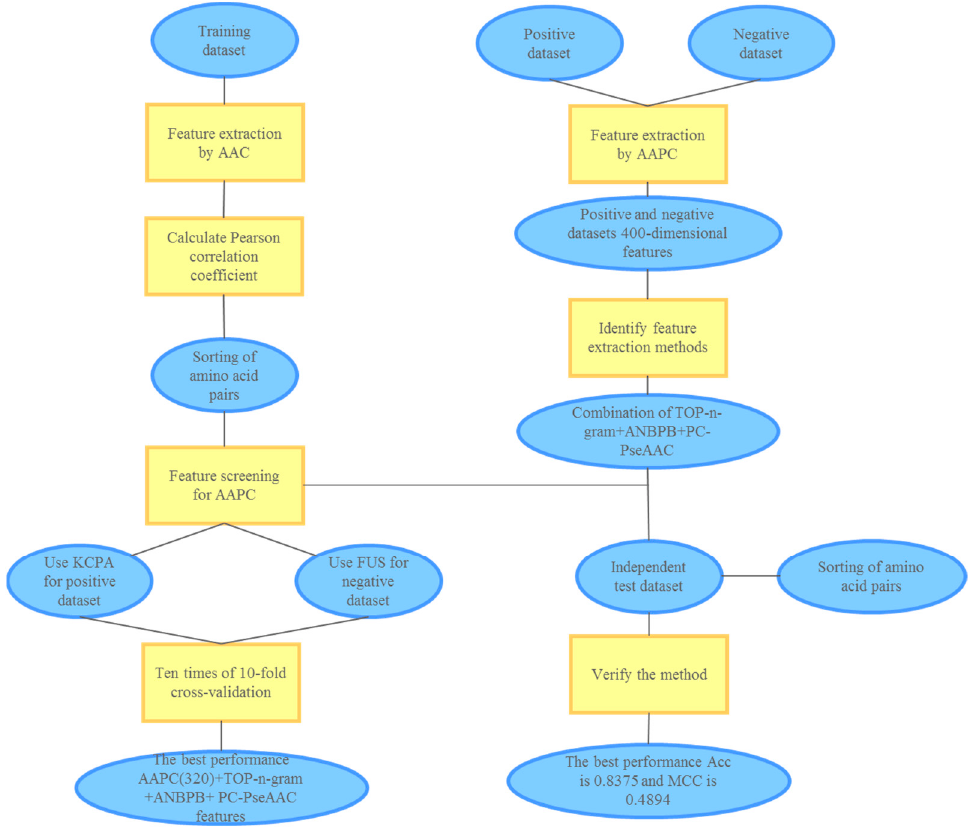
Figure 2. Conceptual diagram of the pupylation site prediction model.